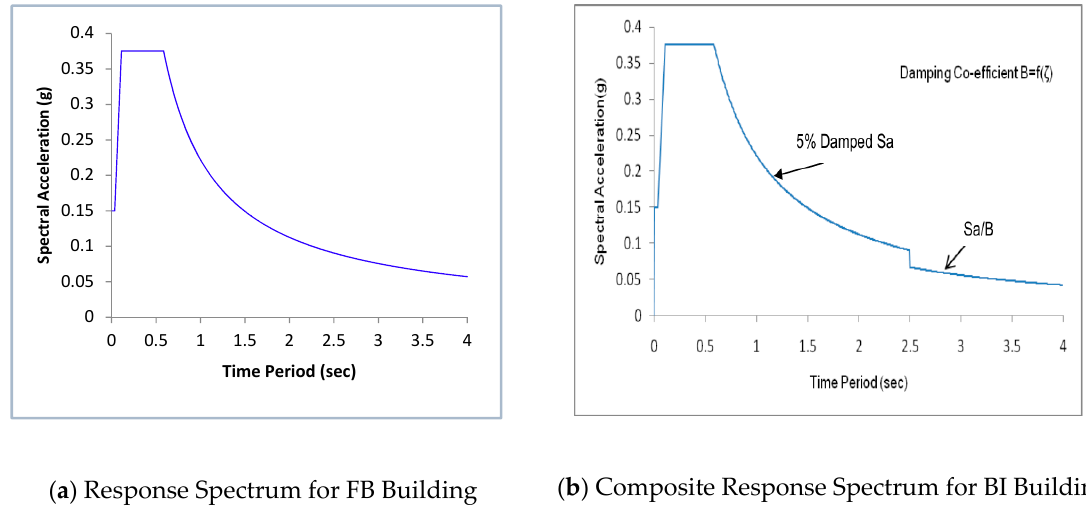
Figure 5. Response spectra for selected ground excitation.